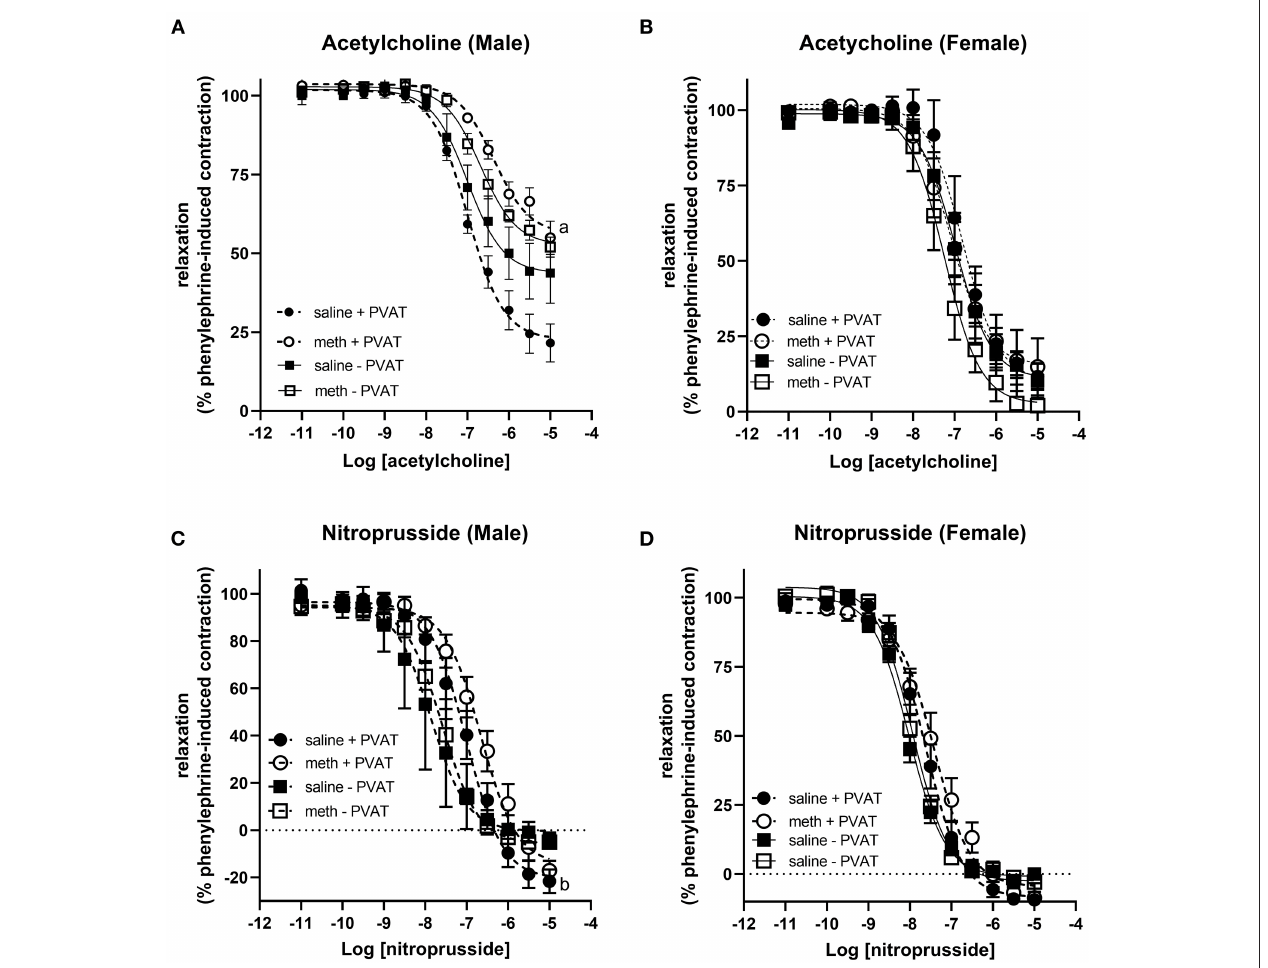
FIGURE 2 | Prenatal methamphetamine causes sex-dependent dysfunction of perivascular adipose tissue in adult aortas. Acetylcholine- and nitroprusside-induced relaxation was measured in the aortas of adult (5 months old) offspring in the presence or absence of PVAT. Two-way ANOVA indicated a significant effect of prenatal methamphetamine [F = 11 (1,21), p < 0.005] and a significant interaction between PVAT and methamphetamine [F = 5 (1, 21), p < 0.05] on the pIC50 of acetylcholine-induced relaxation in male offspring (A) . There was also a significant effect of methamphetamine on the maximal response [F = 8 (1,21), p = 0.01] induced by acetylcholine in male offspring (A) . However, prenatal treatment with methamphetamine had no impact on acetylcholine-induced relaxation in female aortas (B) . Prenatal methamphetamine had no effect on nitroprusside-induced relaxation in male (C) or female (D) aortas. a indicates a significant difference ( p < 0.05) compared to saline + PVAT. b indicates a significant difference ( p < 0.05) compared to saline – PVAT.